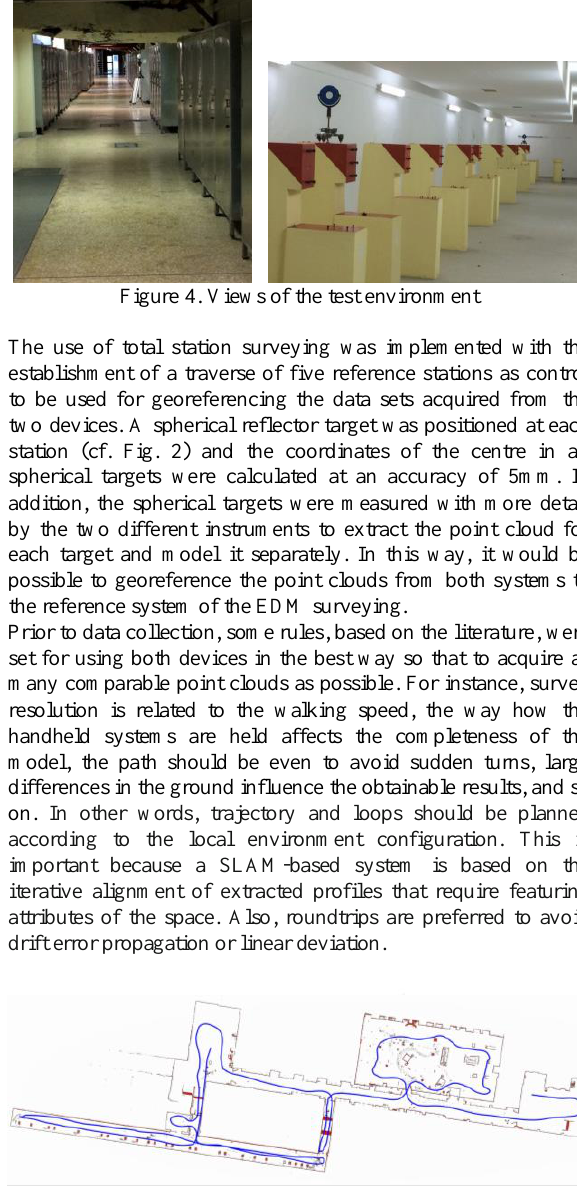
Figure 5. Test footpaths (a) path 1, open; (b) path 2,